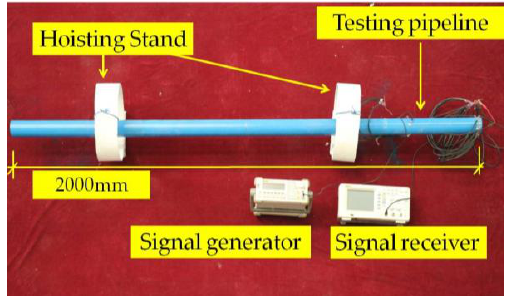
Figure 21. The setup of the pipe structure health monitoring test platform.